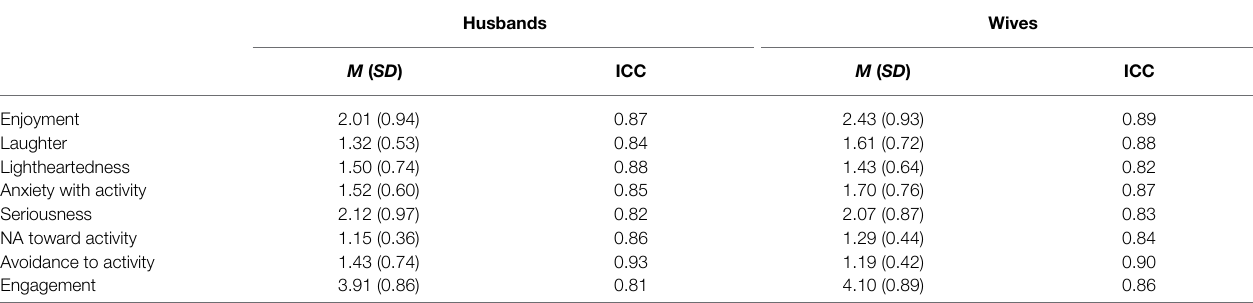
TABLE 1 | The coding scores and ICCs for husbands and wives.